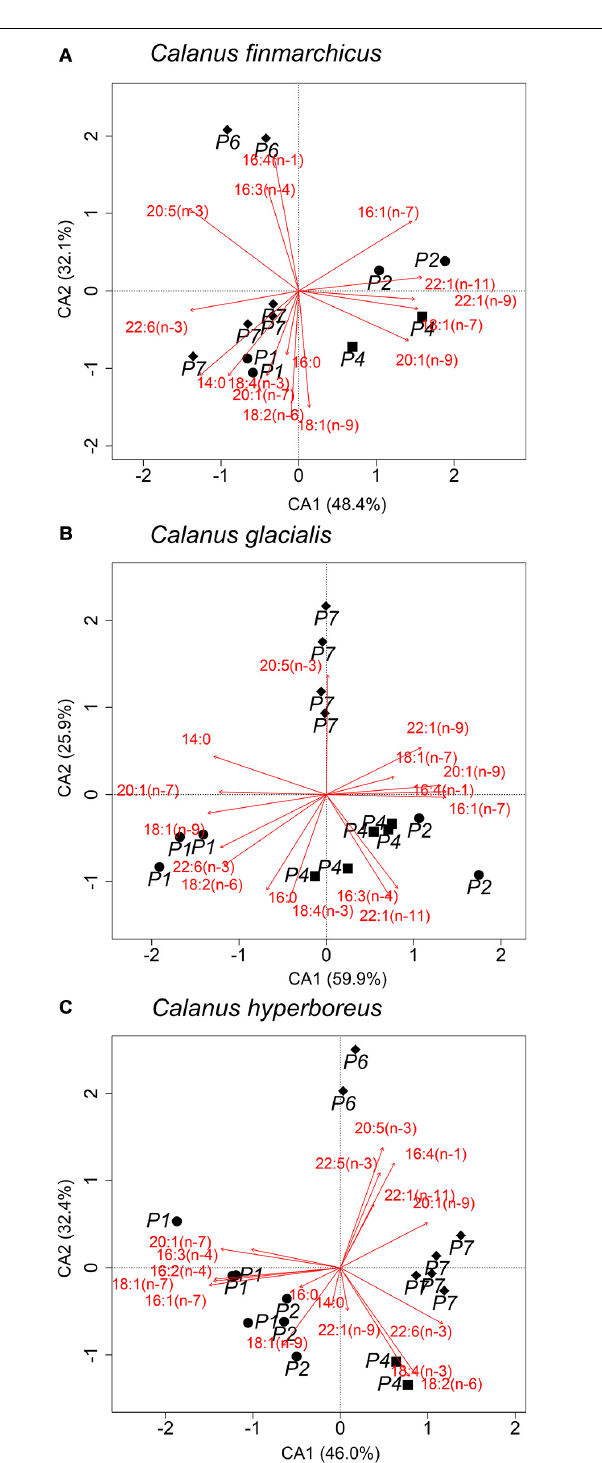
FIGURE 4 | Contribution biplot of correspondence analysis (CA) of fatty acids ( ≥ 1% to the total FA content) representing spatial variability in (A) Calanus finmarchicus , (B) C. glacialis and (C) C. hyperboreus collected during Nansen Legacy cruise Q3 in August 2019 in the Barents Sea. Shapes represent sampling locations with different sea ice concentrations (P1 and P2: ice-free; P4: close to ice edge; P6 and P7: